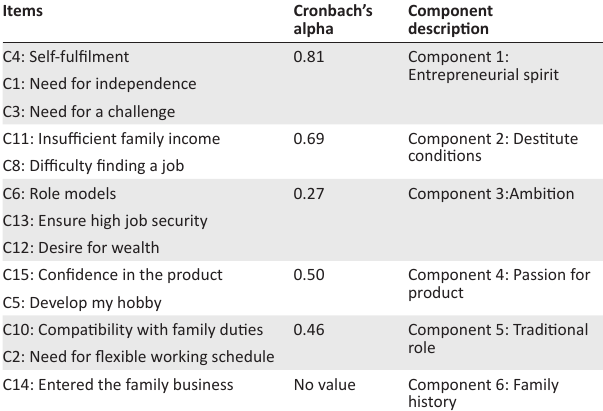
TABLE 6: Transformed components: Motivation to start a business.